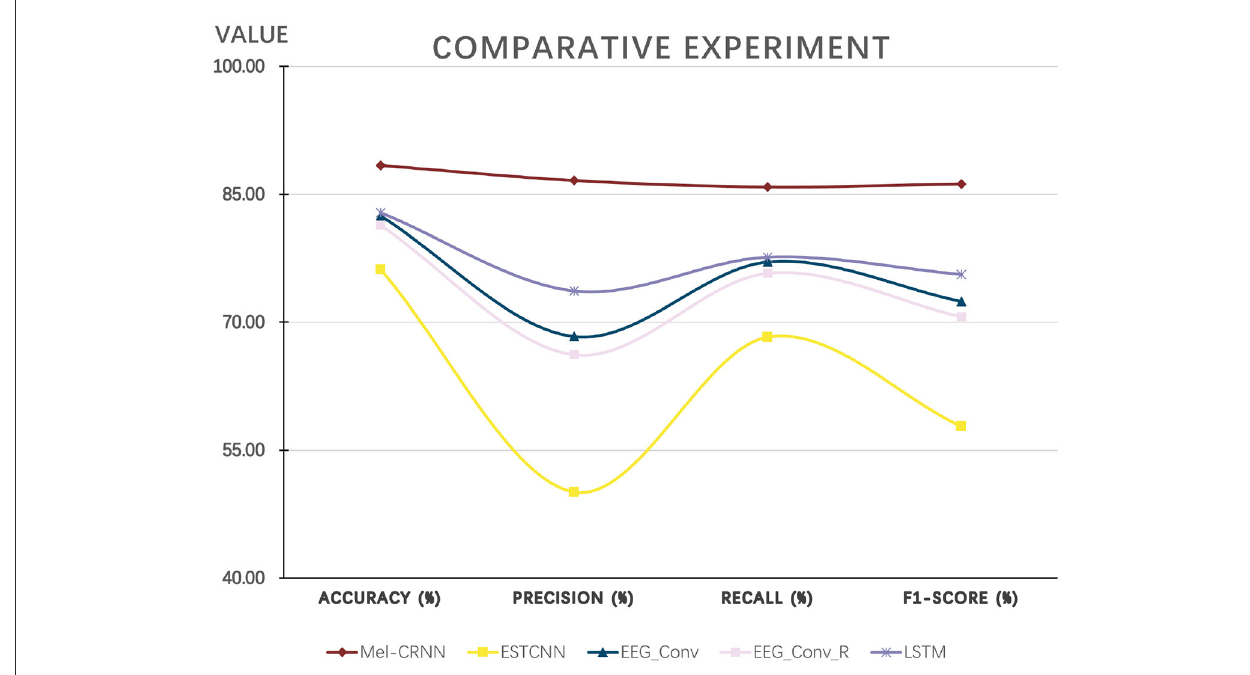
FIGURE7 Experimental results compared with existing